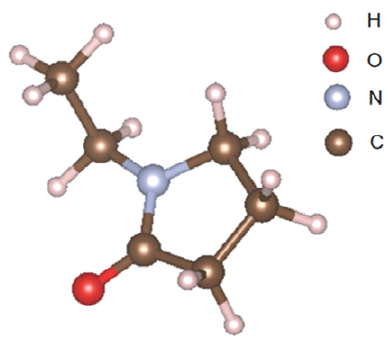
Figure 3. Schematic diagram of PVP monomer molecule